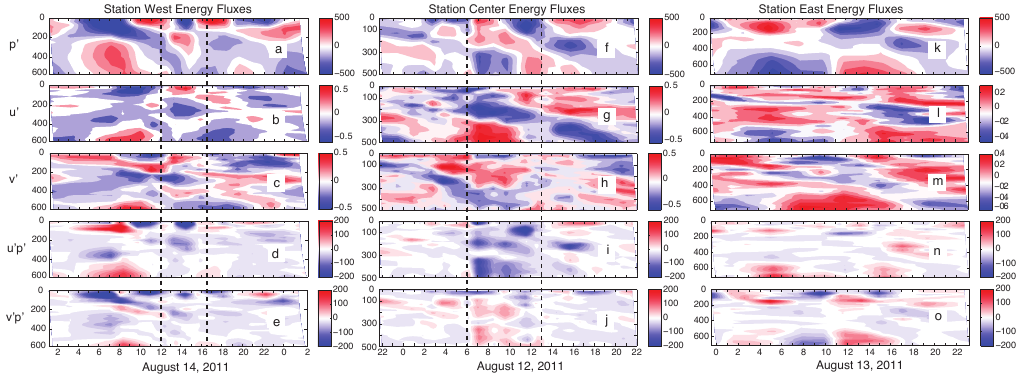
Figure 9. Terms in the energy flux equation for anchor stations west (left column), center (middle), and east (right). From top to bottom, the panels are the baroclinic pressure fluctuation, zonal velocity fluctuation, meridional velocity fluctuation, and the corresponding pressure work terms. The vertical dotted lines indicate times when the mode-2 waves were present.